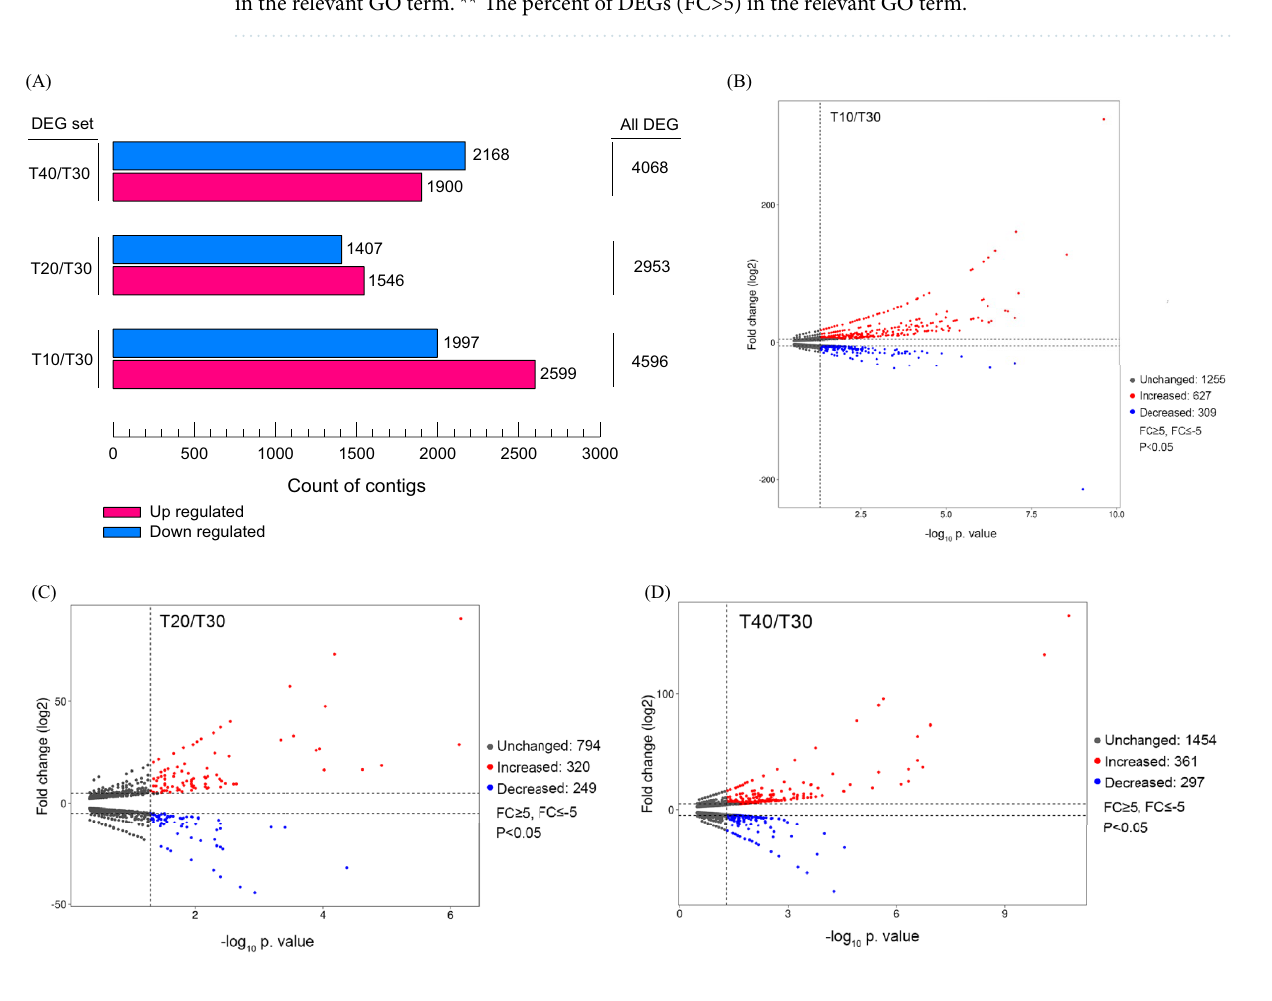
Figure 3. Significant Differentially Expressed Gene (DEG) analysis. ( A ) The number of all up and down- regulated contigs based on p-value < 0.05 and log 2 FC ≥ 2 or log 2 FC ≤ -2 of comparison pairs was plotted. ( B – D ) Volcano diagram for distribution of the identified DEGs in three different treatment groups in comparison with T30 as control. Red and blue points represent significant DEGs with p -value < 0.05 and log 2 FC ≥ 5 or log 2 FC ≤ -5 and grey ones show those without significant,